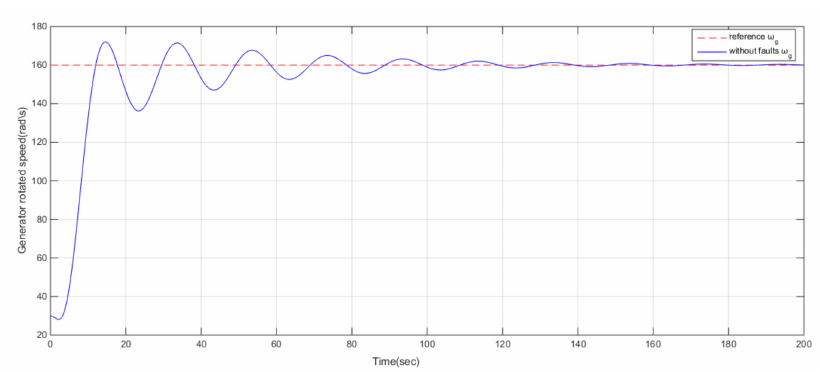
Figure 2. Generator speed predicted without faults.